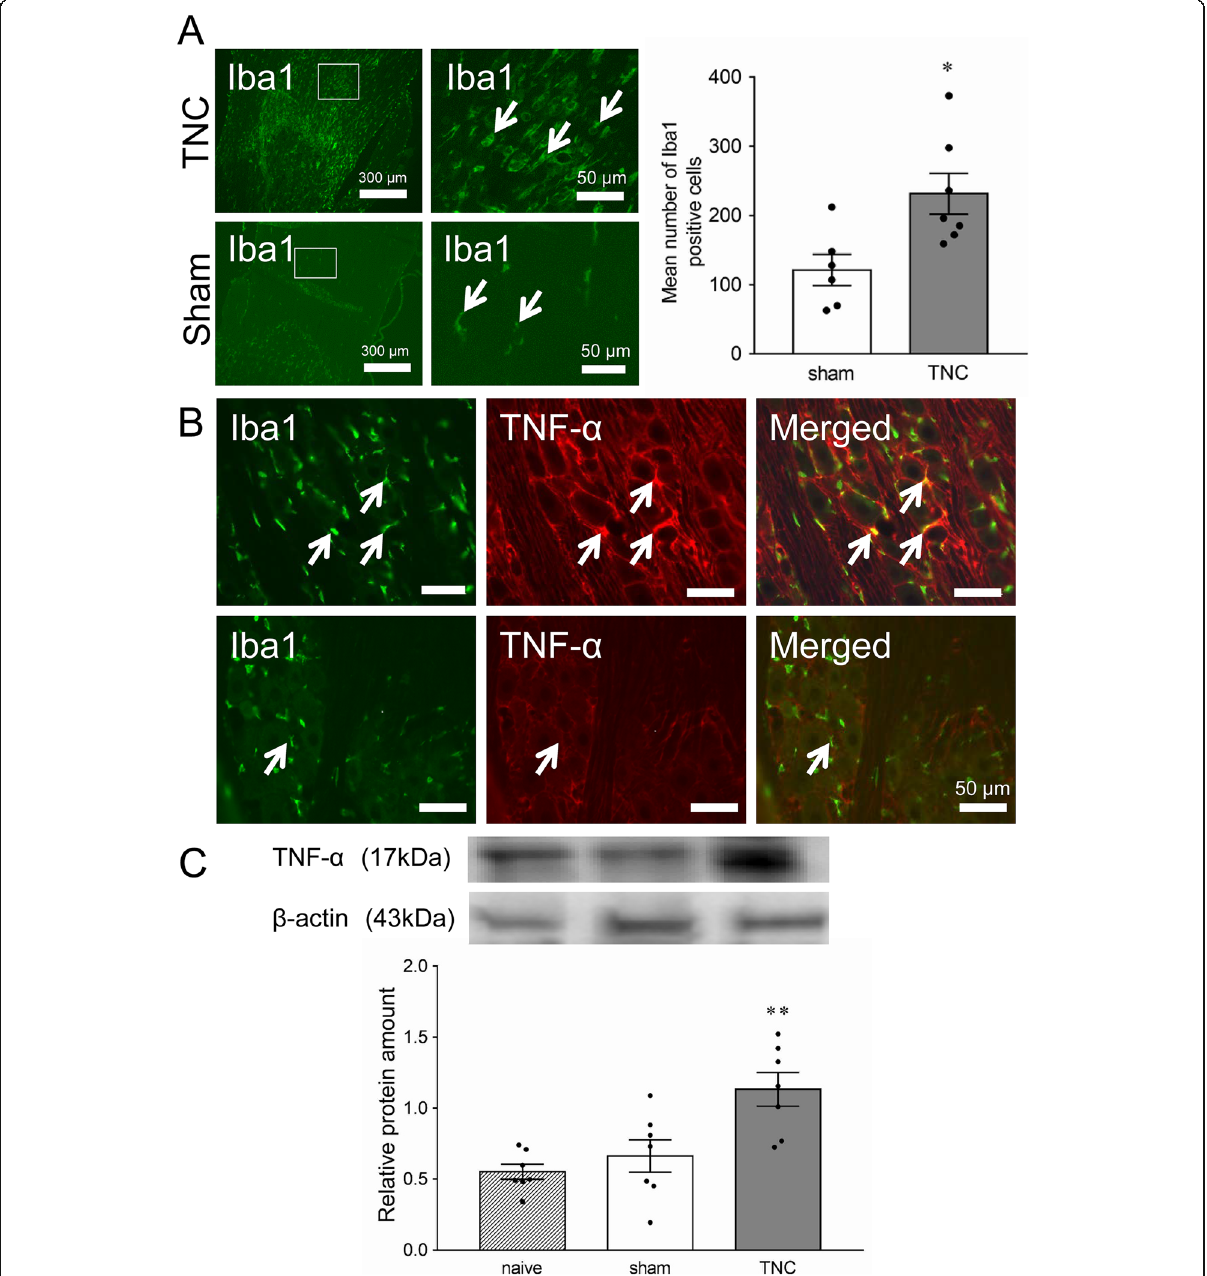
Fig. 2 TNF α and Iba1 expression in the TG on day 7 following TNC or sham procedure. a Photomicrographs of Iba1-IR cells in the depressed trigeminal root on day 7 following TNC or sham treatment. The right image shows an enlarged image surrounded by a white frame. Arrows indicate Iba1-IR cells in the depressed trigeminal root. Mean number of Iba1-positive cells in the TG section on day 7 following the TNC or sham procedure. * p <0.05 vs. sham. ( n =6 in each, student ’ s t -test). b Photomicrographs of TNF α -IR and Iba1-IR cells in the TG on day 7 following TNC or sham treatment. Arrows indicate TNF α -IR and Iba1-IR cells in the TG. Scale bar: 100 μ m. c Relative amount of TNF α protein in the TG in naive rats or on day 7 following the TNC or sham procedure. ** p <0.01 vs. sham. ( n =6 in each, F=9.57, one-way ANOVA with Tukey ’ s multiple comparison